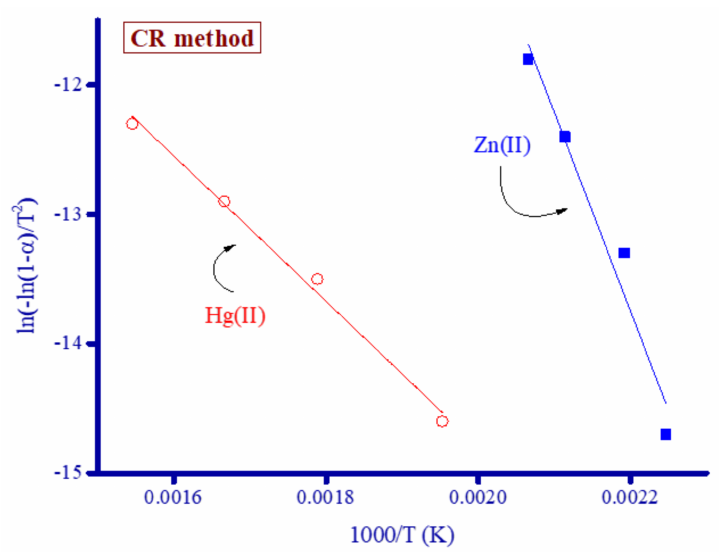
Figure 12. Thermodynamic graphs of Zn 2+ and Hg 2+ complexes derived using the CR